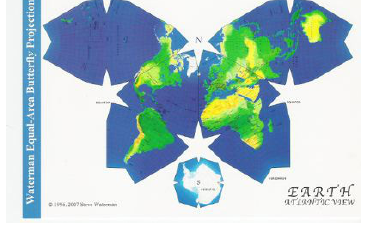
Fig. 15. S. Waterman’s “butterfly” map (source: Gene Keyes Wwebsite)